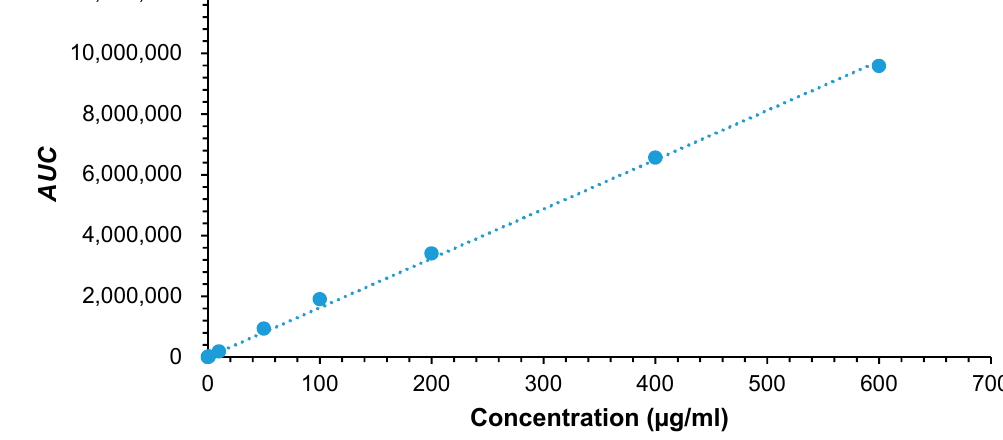
Figure 1. Lidocaine HPLC calibration curve.